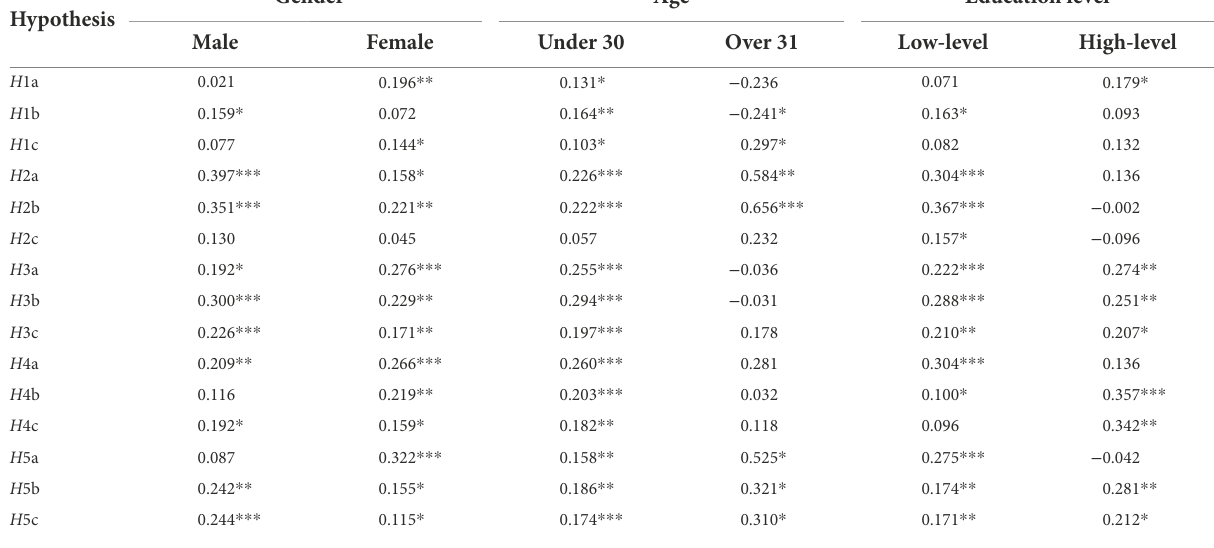
TABLE 5 Estimation results of multi-group